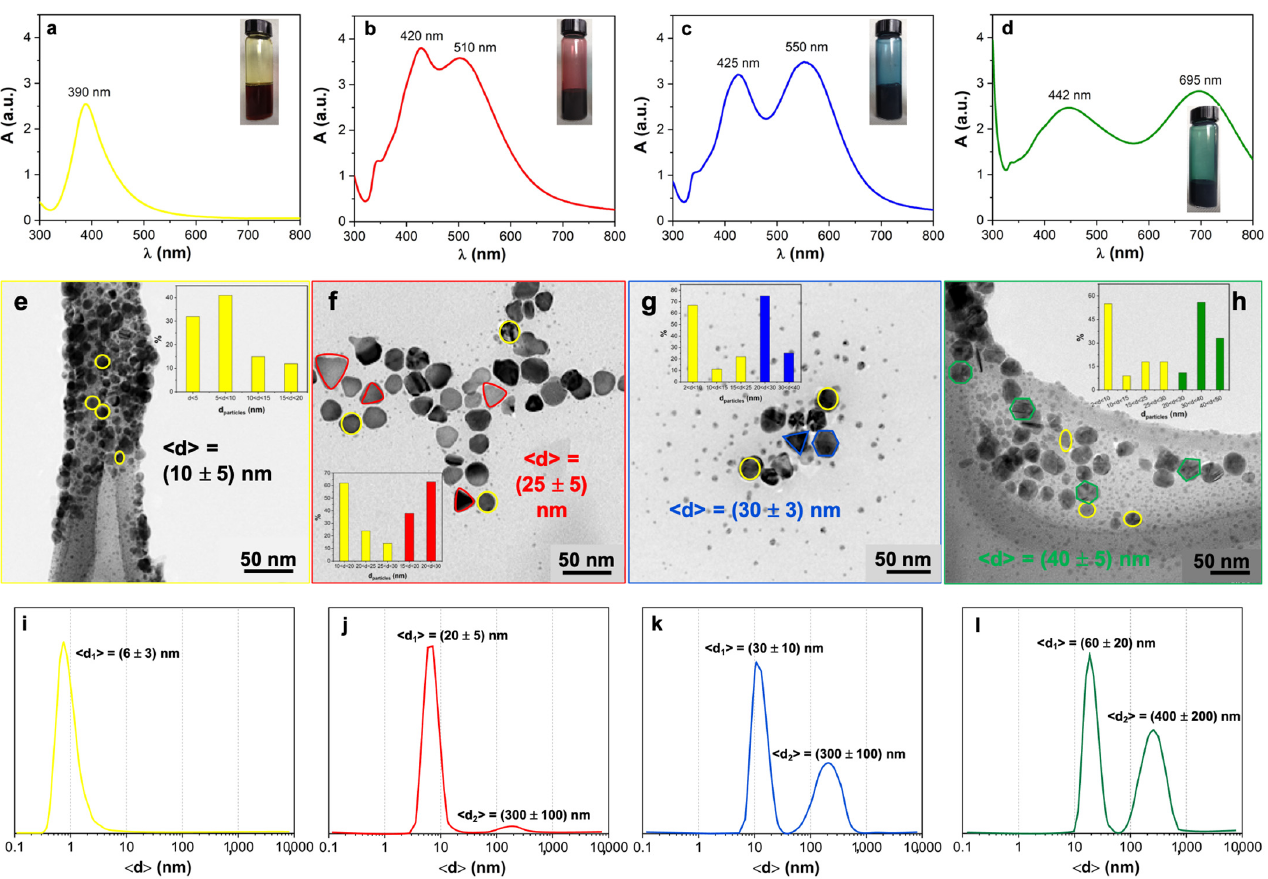
Figure 1. ( a – d ) UV/Vis spectra relative to PVP-based concentrated Ag sols (insets: photos of the corresponding synthesized colors). ( e – h ) TEM images together with computed particles size distribution, and ( i – l ) dynamic light scattering (DLS) curves by volume, in which average silver nanoparticle (Ag NP) size was evidenced.